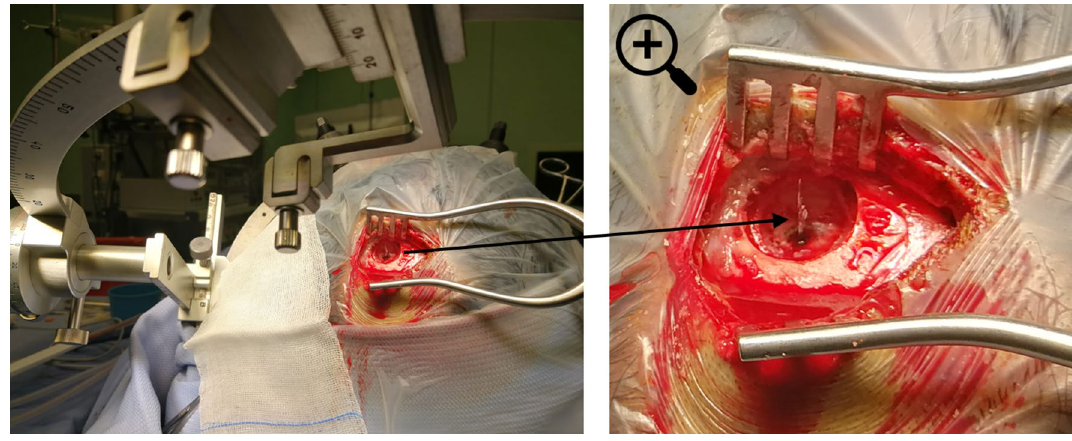
Figure 2. Chemical biopsy of brain tissue with the use of SPME